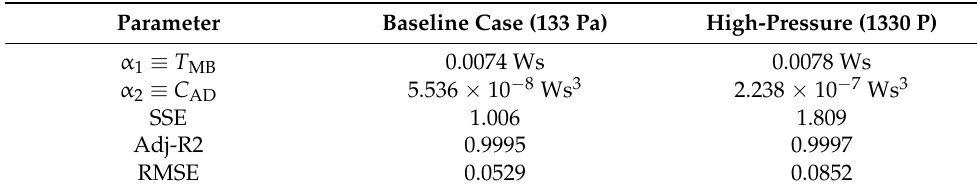
Table 4. Best fit coefficients for the baseline and high-pressure test cases along with goodness of fit statistical parameters (SSE: error sum of squares, Adj-R2: adjusted R-squared, RMSE: root-mean- squared